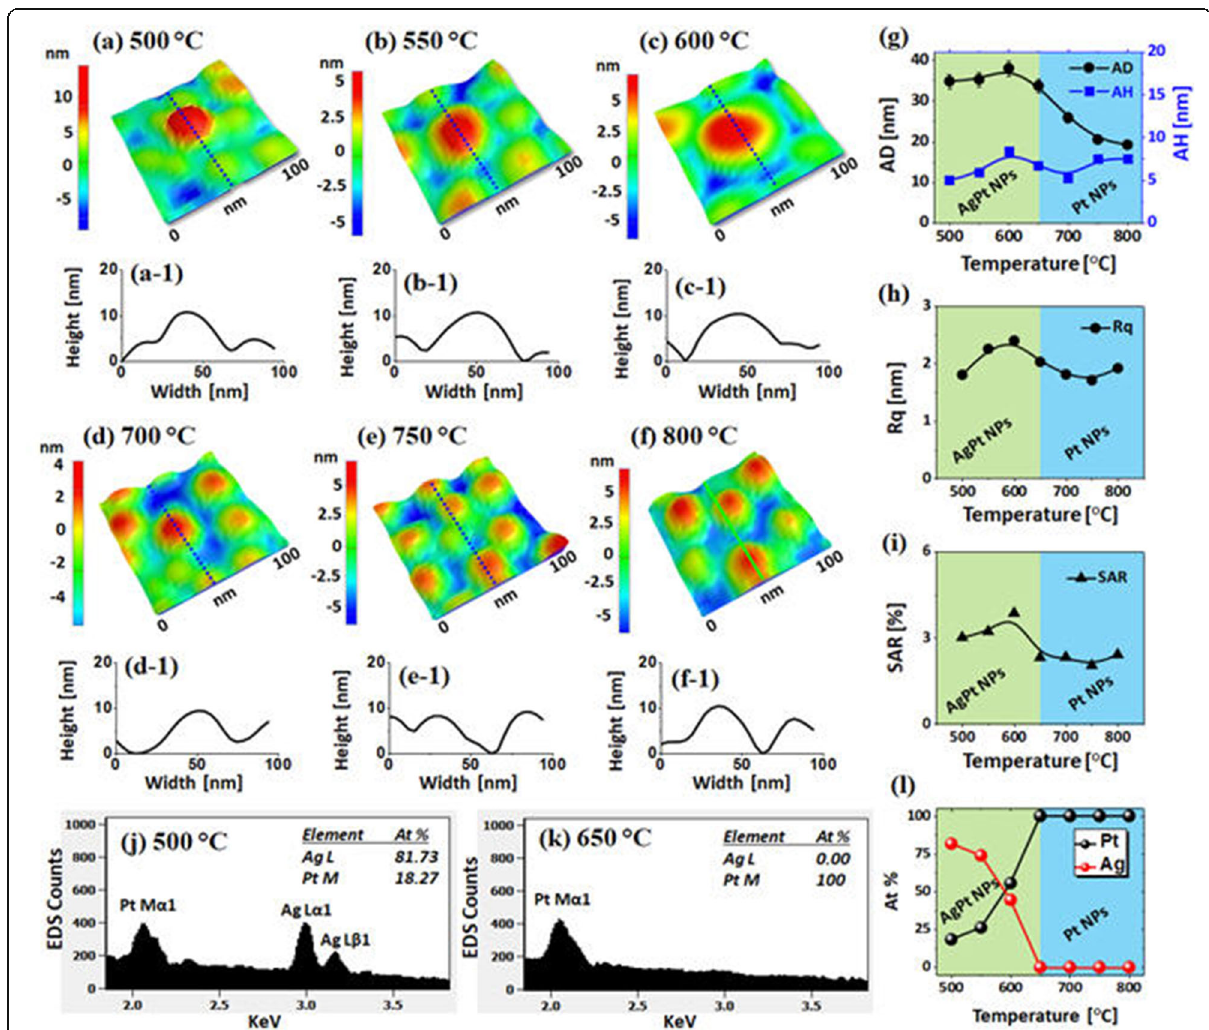
Fig. 3 Evolution of AgPt and Pt NPs from the Ag 5nm /Pt 2.5nm bilayers by annealing between 500 °C and 800 °C for 120 s. a – f AFM side-views. ( a- 1 ) – ( f-1 ) Cross-sectional line profiles. g – i Summary plots of AD, AH, Rq, and SAR. j – k EDS spectra of the AgPt and Pt NPs fabricated at 500 and 650 °C. l Summary plots of at % of Pt and Ag. The elemental composition of Ag and Pt are enclosed in the EDS